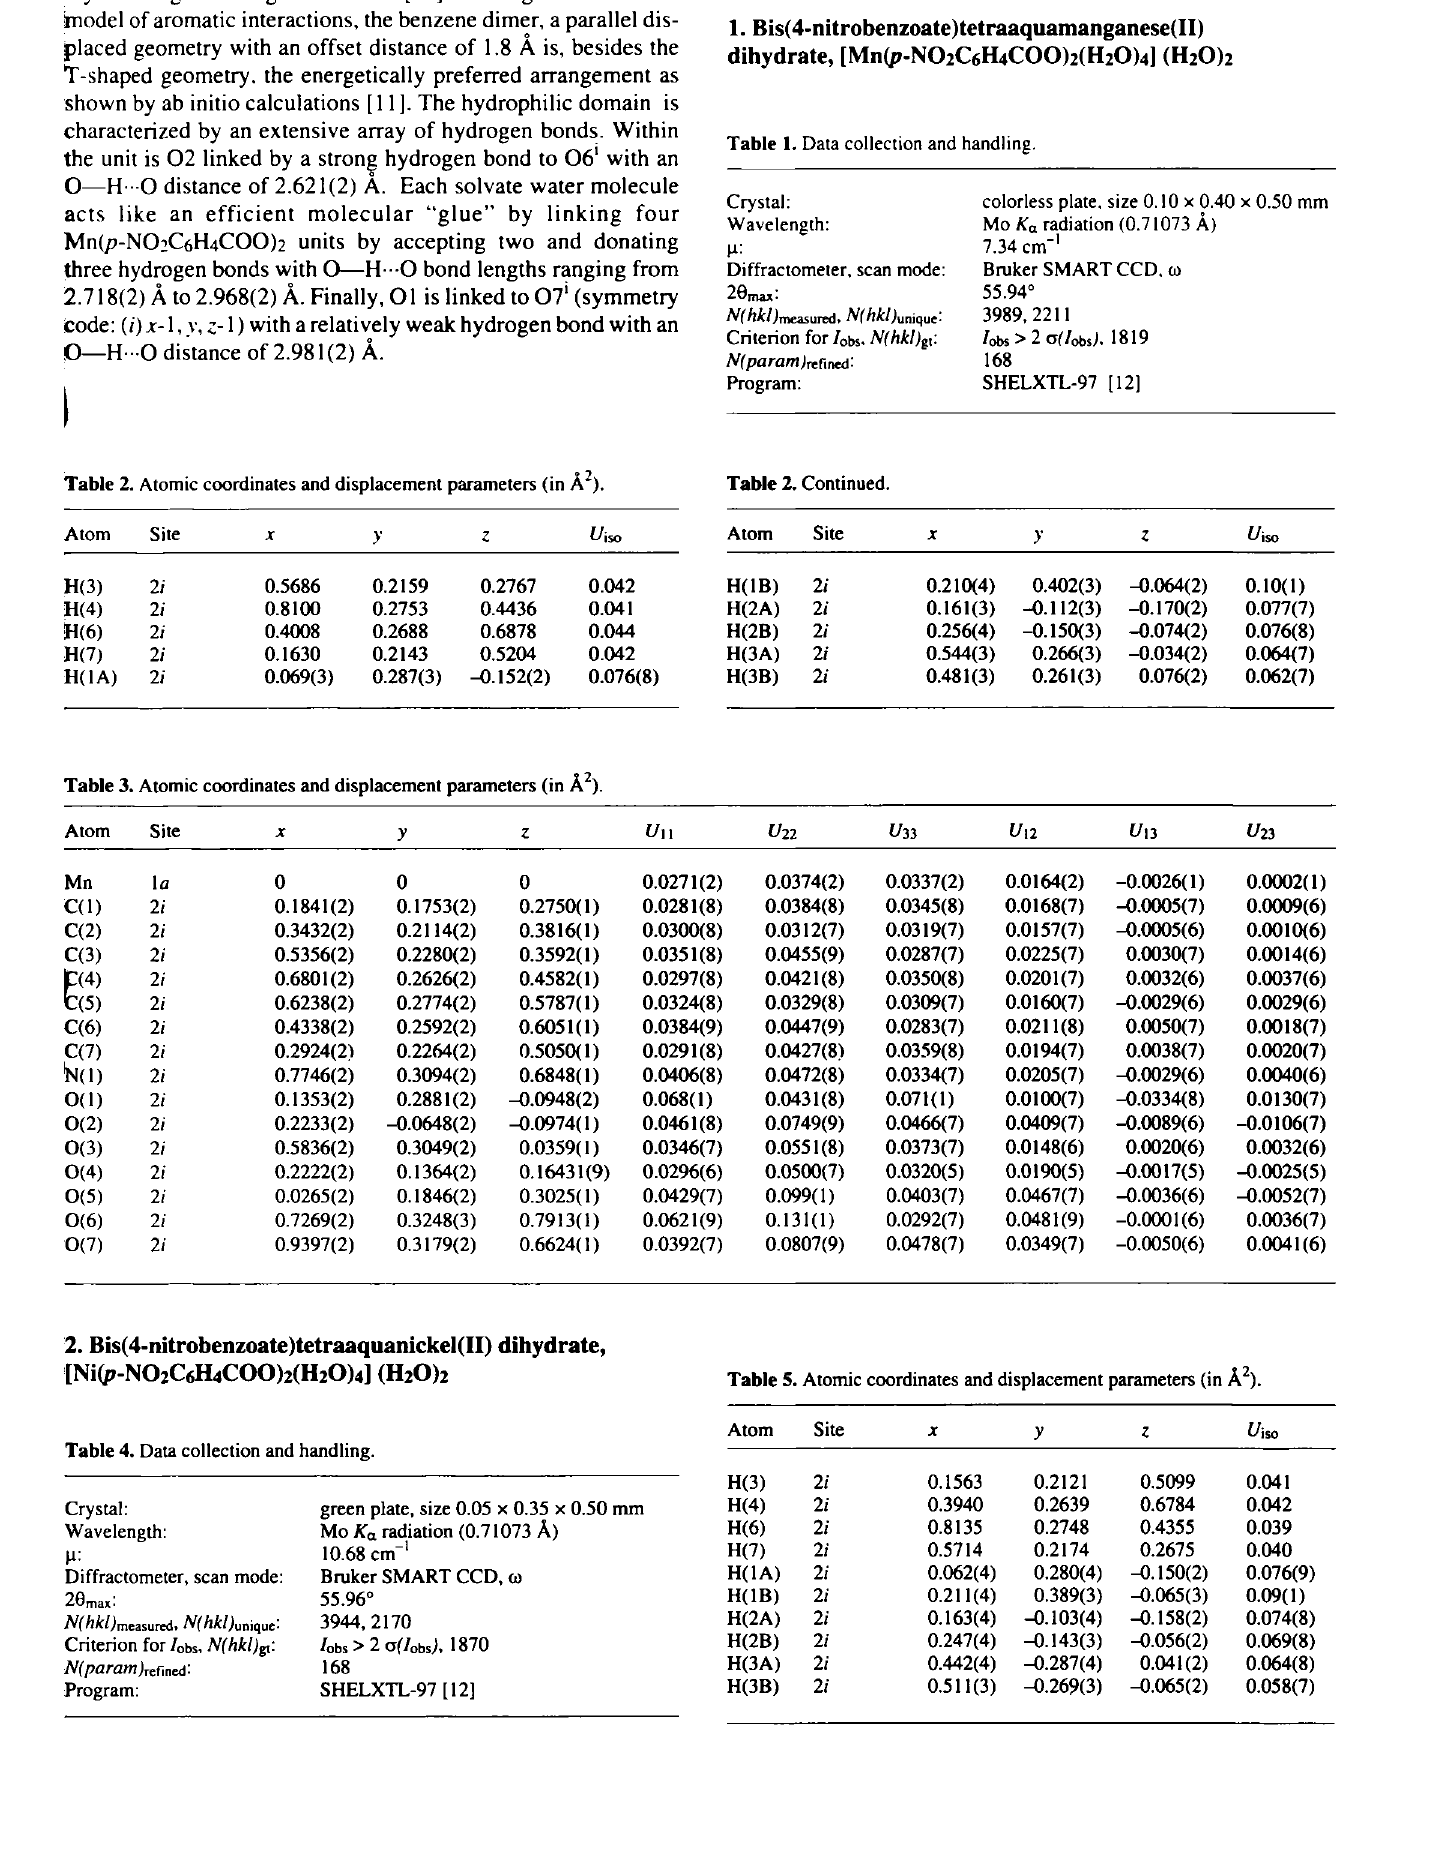
Table 1. Data collection and handling.